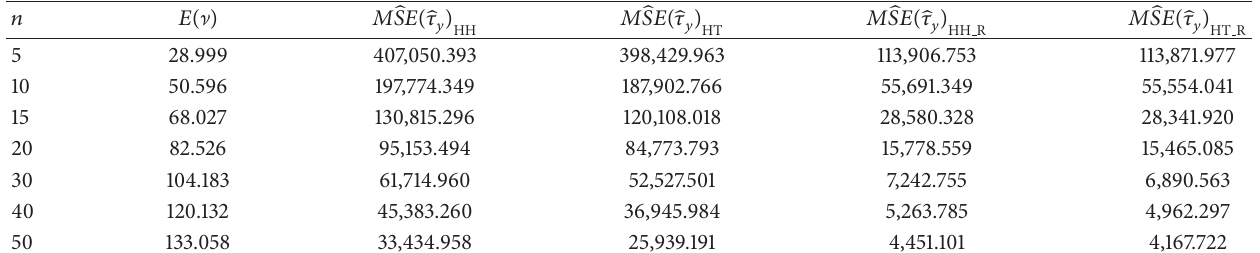
Table 3: The estimated MSE of the Hansen-Horvitz estimator and Horvitz-Thompson estimator for the population total of the variable of interest.